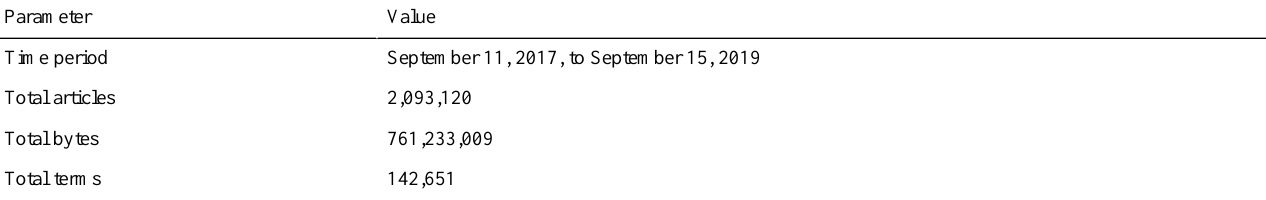
Table 2. Hyperparameters for word embeddings and long short-term memory model training.